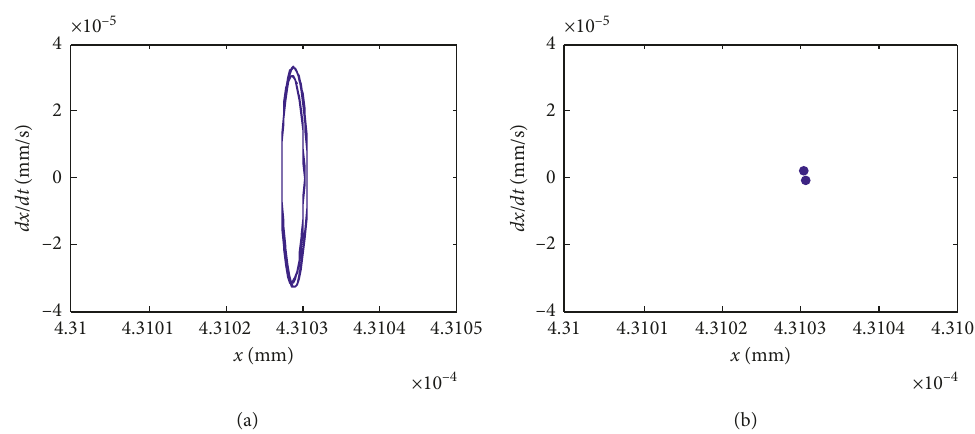
Figure 6: System response for ω � 20000r/min. (a) Phase portraits. (b) Poincar´e map.